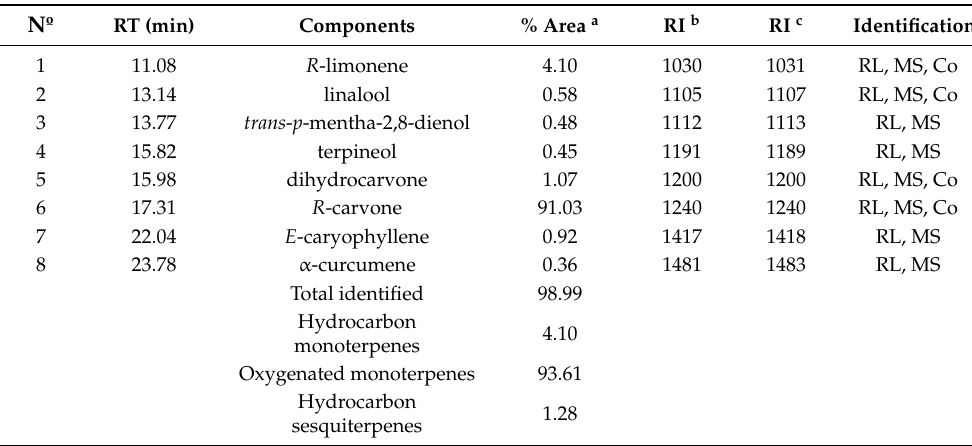
Table 1. Essential oil composition of A. polystachya .